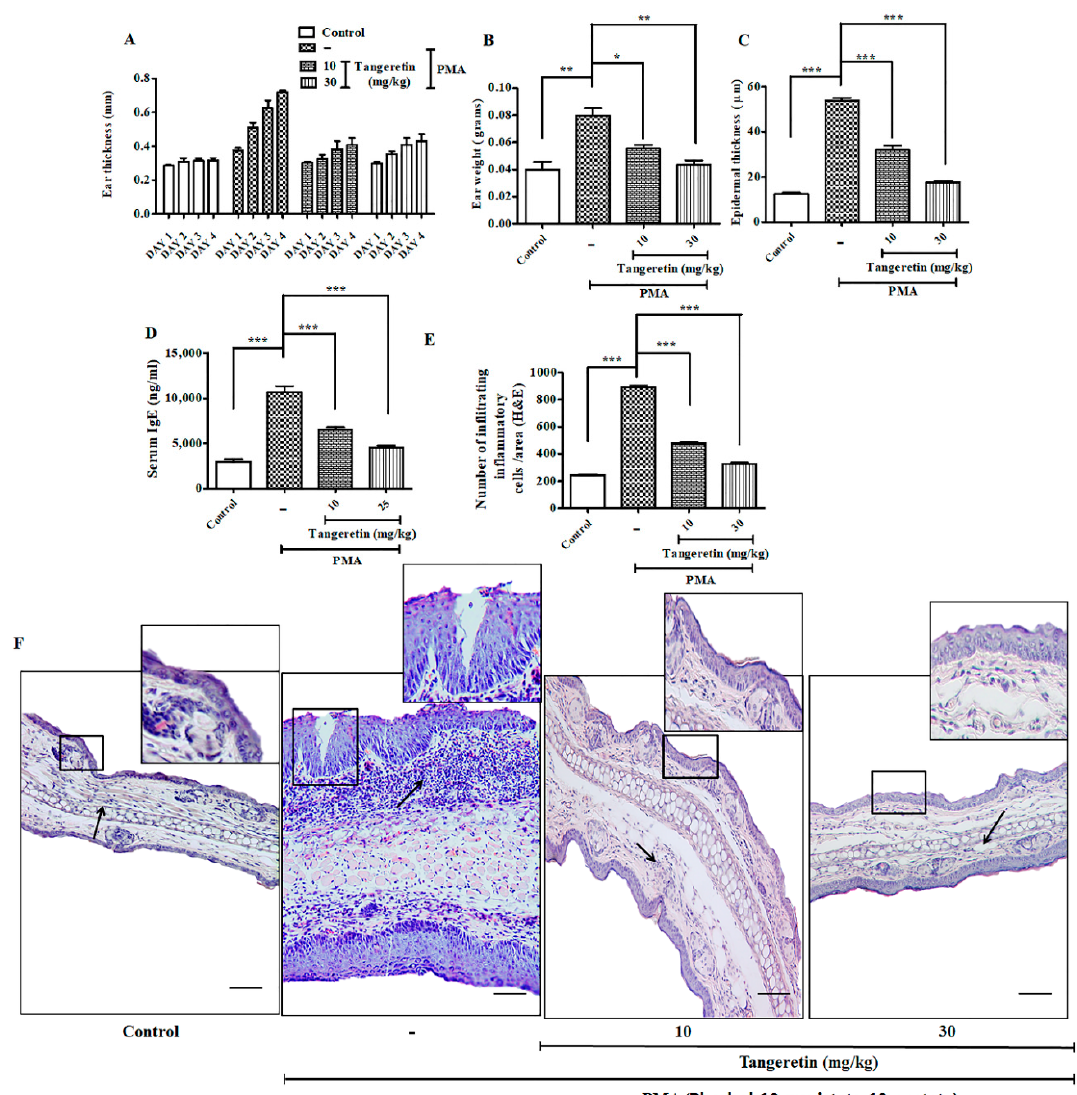
Figure 5. Tangeretin (TAN) remarkably ameliorated PMA induced epidermal hyperplasia intra-epidermal neutrophilic abscesses (mice, n = 5 / group). ( A ) Ear thickness was measured every day after topical treatment of PMA and TAN for 3 days, ( B ) Ear weight of different mice group after sacrifice, ( C ) Epidermal thickness of mice ears measured through hematoxylin and eosin (H&E) staining data, ( D ) Serum IgE estimation from PMA treated mice, ( E ) Estimating the infiltrating inflammatory cells/area from H&E staining images, ( F ) Representative images of mice ear tissues after PMA induced inflammation measured through H&E staining. Square: the regions under the square represent massive re-epithelialization occurring after PMA treatment over a period of 3 days. Newly formed, thick epidermis as observed on PMA group. Black arrow: the marked regions on the images shows highly aggregated granulation tissue and an inflammatory cell rush comprising of scattered neutrophils, macrophages and other inflammatory cells. Scale bar (100 µ M). The data are represented as mean ± S.D. of two independent experiments * p < 0.05, ** p < 0.01, *** p < 0.001 and ns (non-significant). Control vs. PMA, PMA vs. TAN 10 mg / kg and 30 mg / kg. Statistical significance analysis was carried out through a one-way analysis of variance (ANOVA) prism.